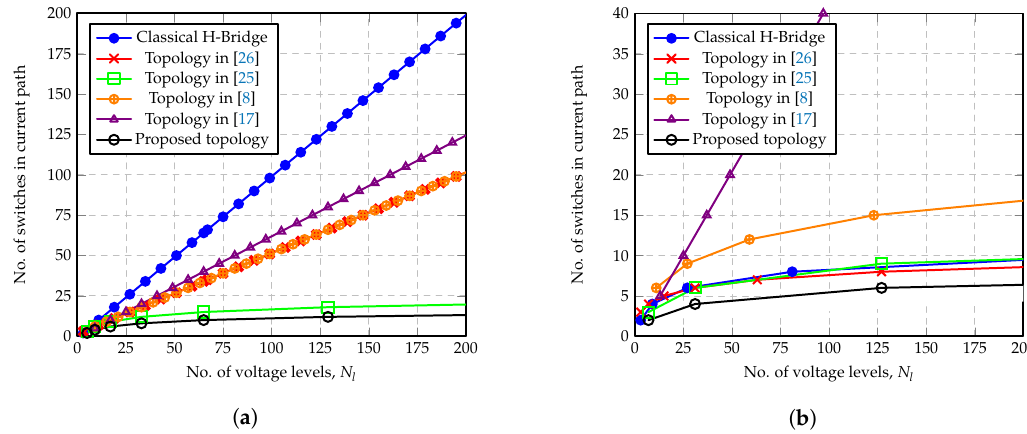
Figure 6. Number of switches in the current path vs. the output voltage level of proposed inverter compared to the other three topologies in ( a ) symmetric mode and ( b ) asymmetric